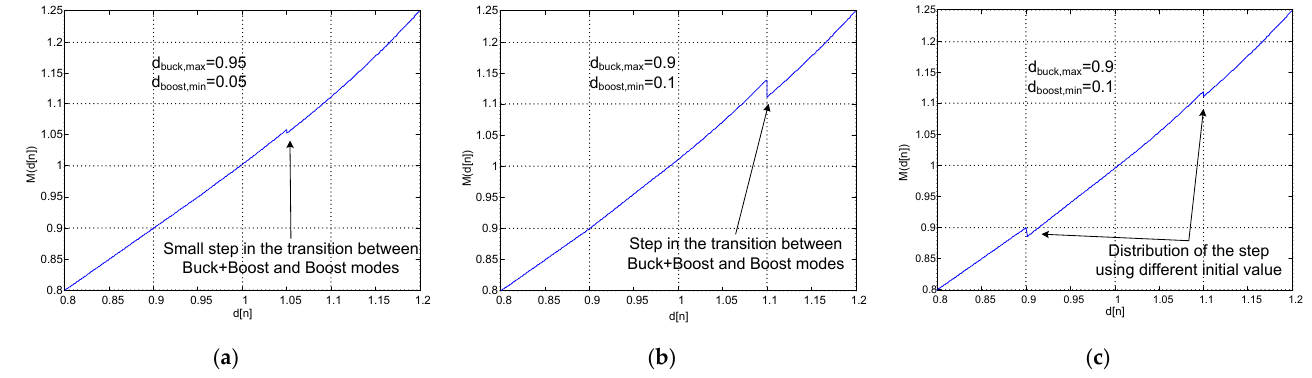
Figure 12. Conversion ratio M(d[n]) using a linear approximation to obtain d buck [n] and d boost [n]. ( a ) Small step in one transition using d buck,max = 0.95 and d boost,min = 0.05. ( b ) Higher step using d buck,max = 0.9 and d boost,min = 0.1. ( c ) Distribution of the step in both